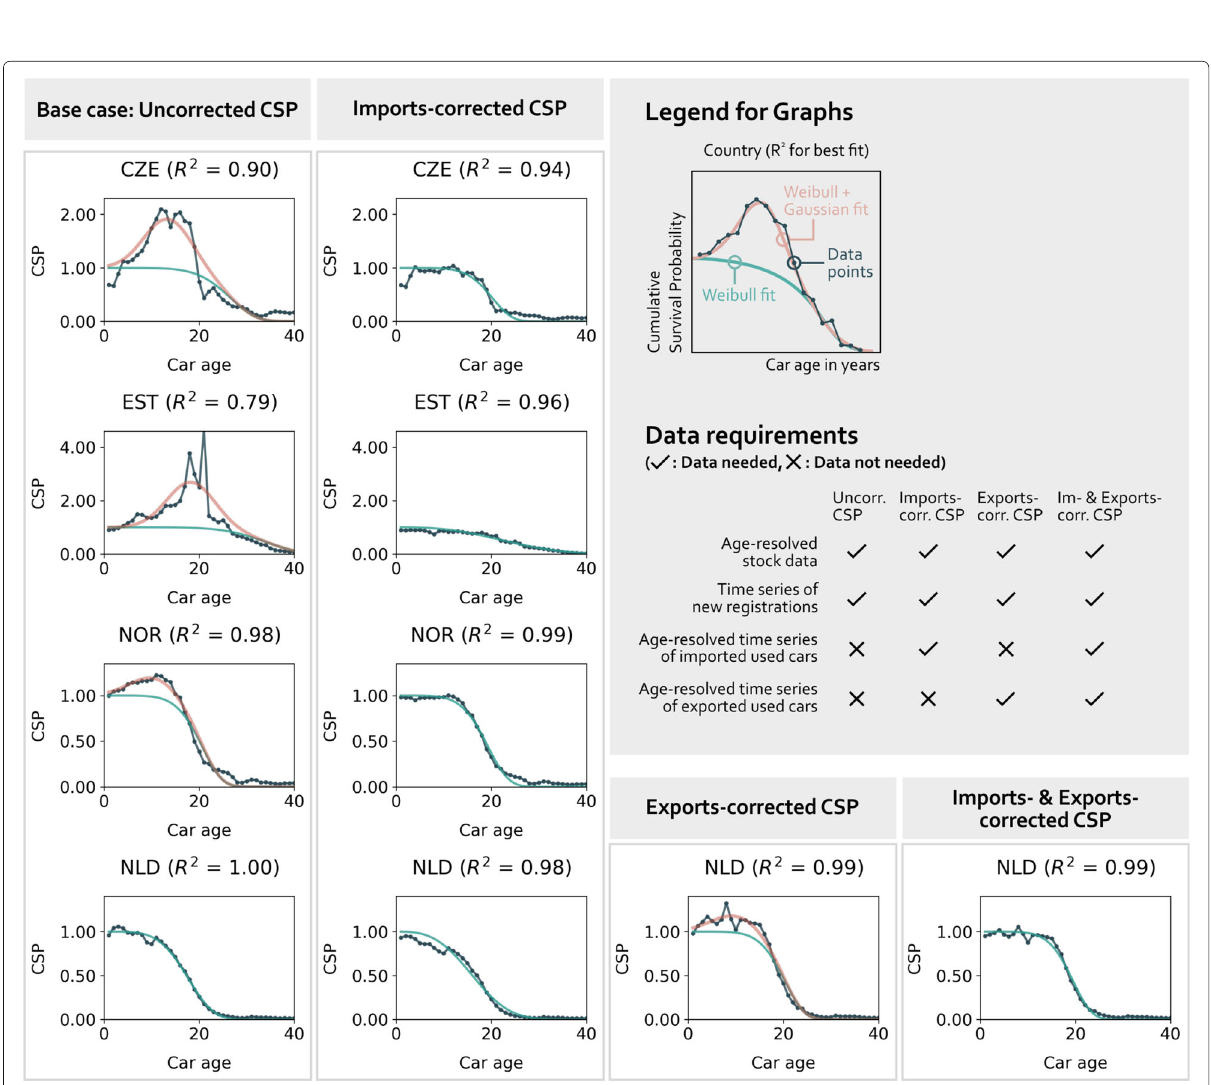
Fig. 5 Proof of concept for new CSP estimation method. The uncorrected CSP curve (left column) is corrected by imported and exported cars (two middle columns) and by both (right column), using Eq. 6. Below the legend, the required data to compute the CSP of each column is